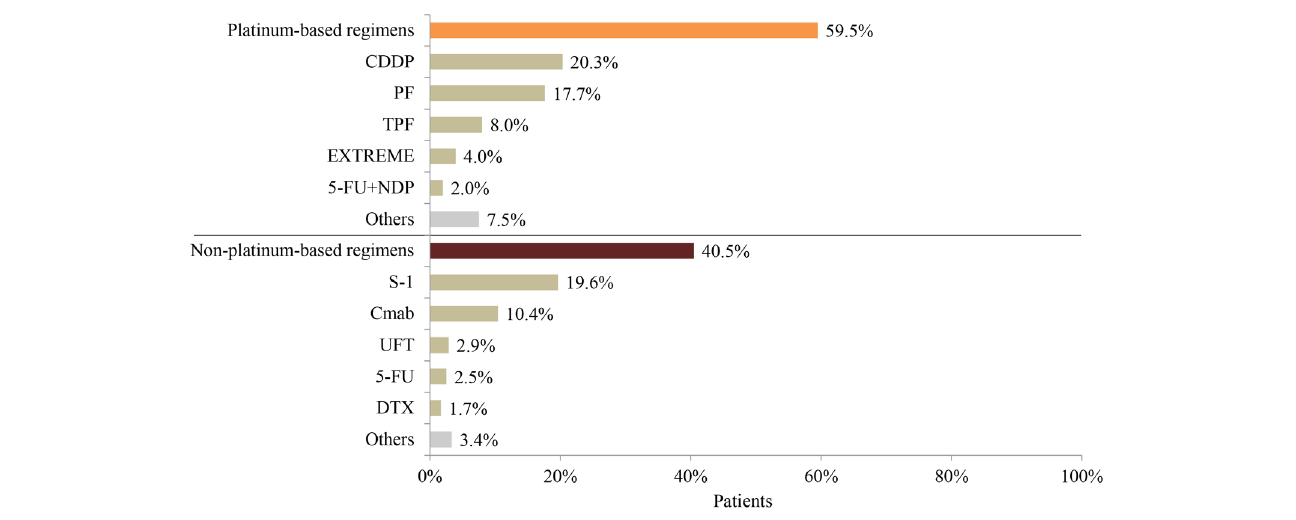
Figure 3. First-Line Treatment Patterns of Systemic Chemotherapy in Recurrent or Metastatic HNC Patients (N=1313)